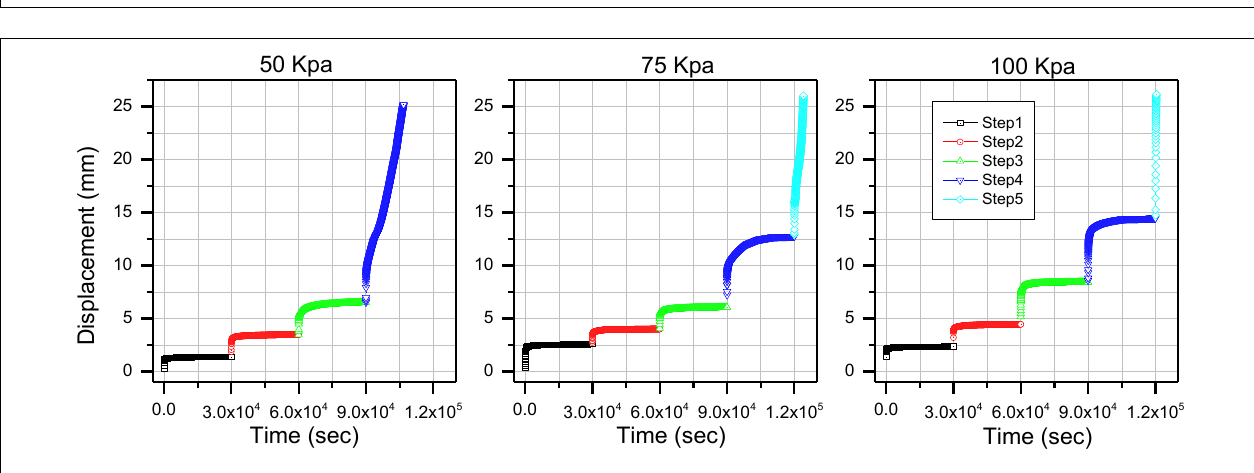
FIGURE 8 | Creep deformation tests curves obtained for different confining